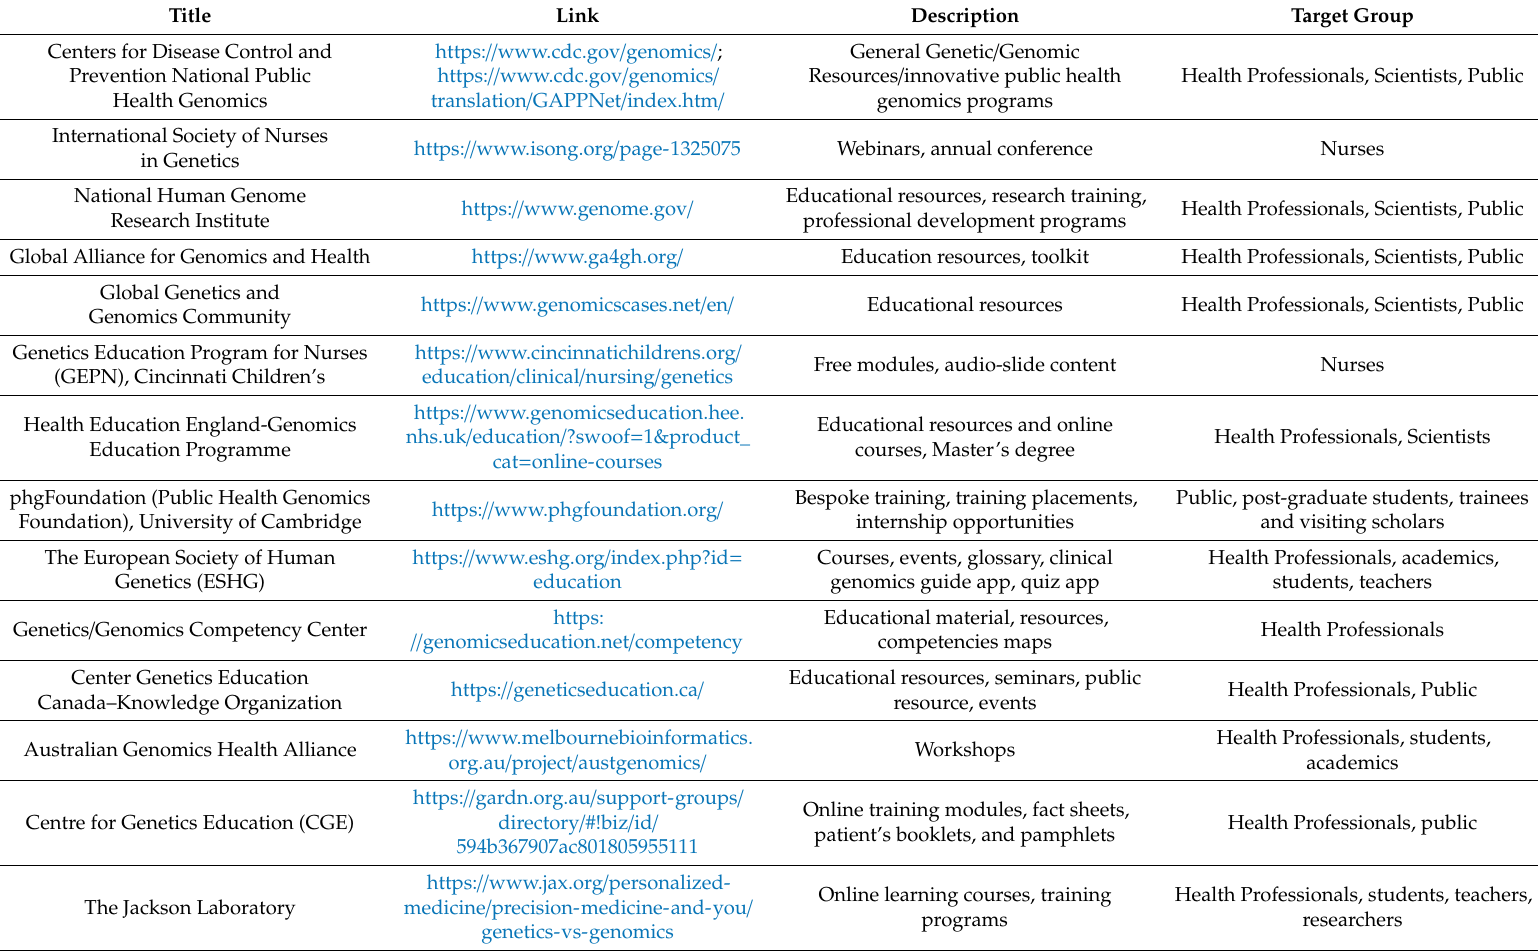
Table 2. Web sources regarding genetic / genomic information for healthcare providers and